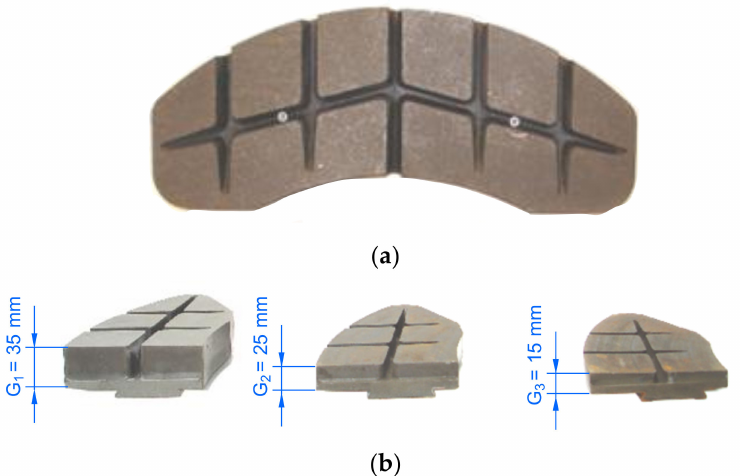
Figure 3. View of the friction linings used during bench tests: ( a ) view with visible expansion grooves, ( b ) side view with visible lining